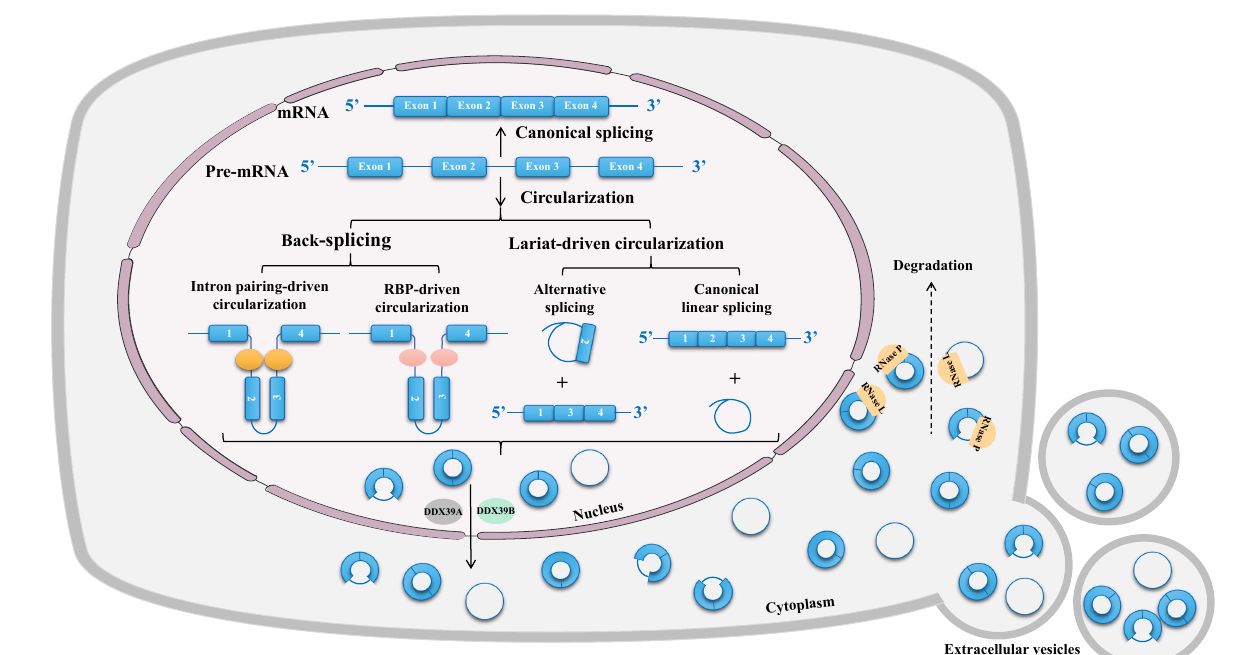
Figure 3. Biogenesis, trafficking, and degradation of circRNA. Different from the canonical splicing that joins an upstream 5 (cid:48) splice site with a downstream 3 (cid:48) splice site; circRNA are produced from back-splicing of precursor mRNA, in which a downstream 5 (cid:48) splice site joins an upstream 3 (cid:48) splice site in reverse order. In addition, intron lariats from conventional splicing can retain a circular form when escape debranching. Apart from biogenesis, trafficking and degradation also regulate the abundance of circRNA. Nuclear export of circRNAs to the cytoplasm occurs in a length-dependent manner and requires multiple proteins, such as spliceosome RNA helicase DDX39B (for long circRNAs) and ATP-dependent RNA helicase DDX39A (for short circRNAs). CircRNA also can be degraded by endonucleases or further exported to extracellular